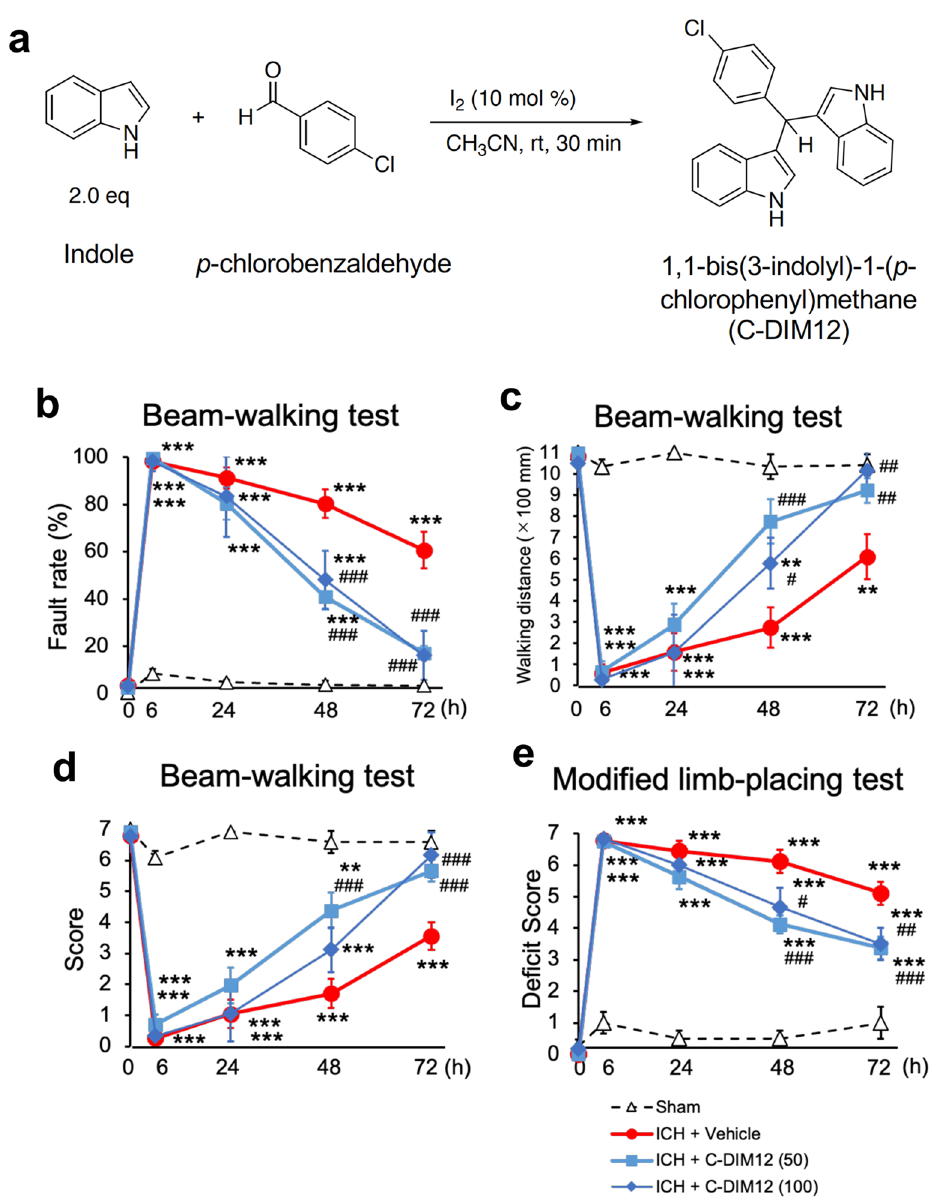
Figure 1. Synthesis of C-DIM12 and effect of C-DIM12 on motor functions of mice after ICH. ( a ) The chemical reaction used for the synthesis of C-DIM12. ( b–d ) Results of performance in the beam-walking test which was evaluated by foot fault rate ( b ), walking distance ( c ) and performance score ( d ). C-DIM12 (50 or 100 mg/kg) or vehicle was orally administered at 3 h, 27 h and 51 h after ICH induction. Concerning the fault rate, significant differences between two groups were observed (two-way repeated measure ANOVA: interactions, F 12,92 = 17.11, P < 0.001; time, F 4,92 = 164.4, P < 0.001; treatment, F 3,23 = 62.96, P < 0.001). Concerning the walking distance, significant differences between two groups were observed (two-way repeated measure ANOVA: interactions, F 12,92 = 9.581, P < 0.001; time, F 4,92 = 87.77, P < 0.001; treatment, F 3,23 = 23.17, P < 0.001). Concerning the performance score, significant differences between two groups were observed (two-way repeated measure ANOVA: interactions, F 12,92 = 11.48, P < 0.001; time, F 4,92 = 125.5, P < 0.001; treatment, F 3,23 = 32.26, P < 0.001). ( e ) Results of performance in the modified limb-placing test. Significant differences between two groups were observed (two-way repeated measure ANOVA: interactions, F 12,92 = 14.92, P < 0.001; time, F 4,92 = 180.5, P < 0.001; treatment, F 3,23 = 49.86, P < 0.001). Number of mice examined in ( b - e ) was 4 in sham group, 9 in ICH + vehicle group, 8 in ICH + C-DIM12 (50 mg/kg) group and 6 in ICH + C-DIM12 (100 mg/ kg) group, respectively. ** P < 0.01, *** P < 0.001 versus sham group, # P < 0.05, ## P < 0.01, ### P < 0.001 versus ICH + vehicle